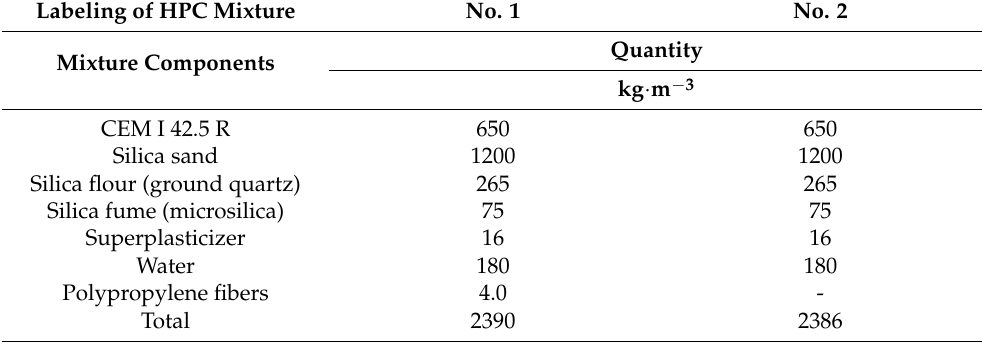
Table 4. HPC mixtures